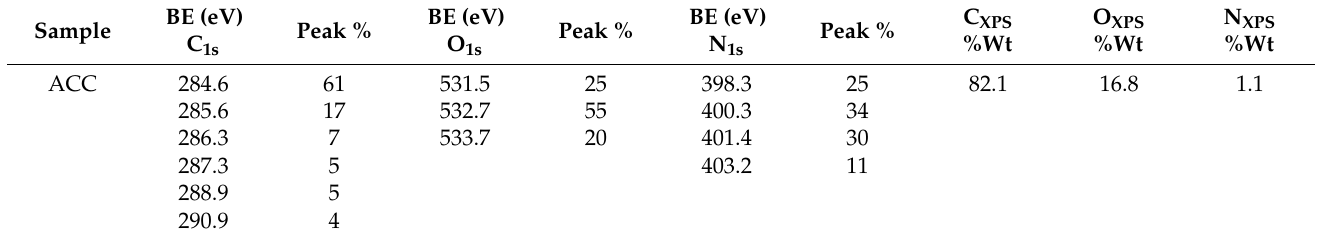
Table 2. XPS results of ACC: the C, O, and N surface contents (C XPS , O XPS , and N XPS ), binding energy, and percentage of the components used to fit the C 1s , O 1s , and N 1ps spectral